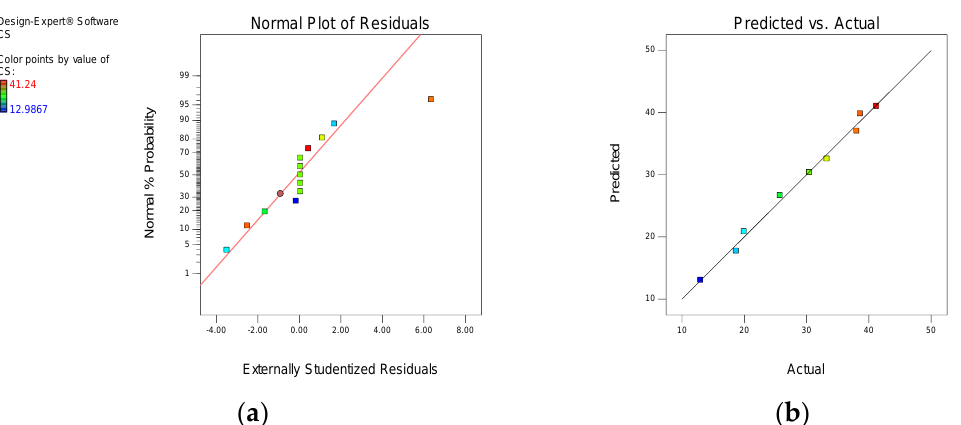
Figure 16. ( a ) Normal Plot for the Residual and ( b ) Predicted Versus Actual Plot for the CS model.